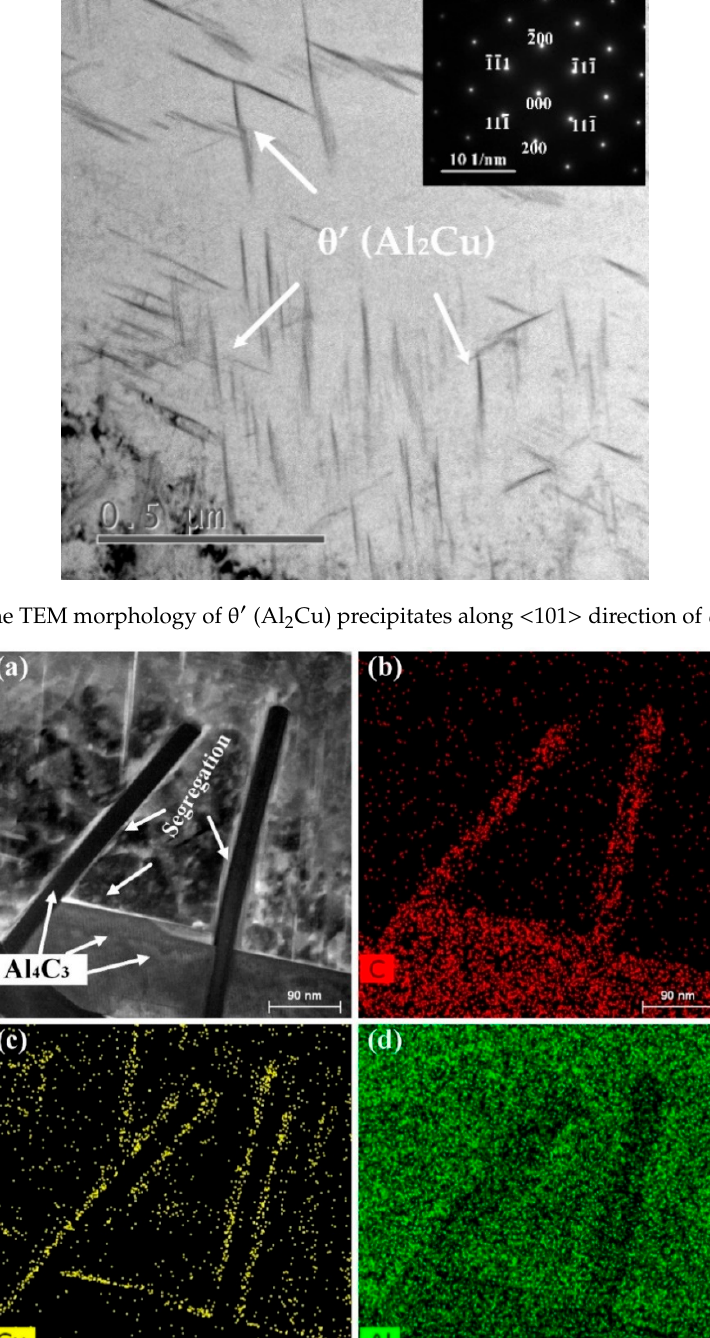
Figure 6. ( a ) High angle annular dark field (HADDF) STEM image (Z-contrast) for the interfacial microstructure of the SCFs/2024 Al composite, ( b – d ) EDS mapping analysis for Figure 6a.